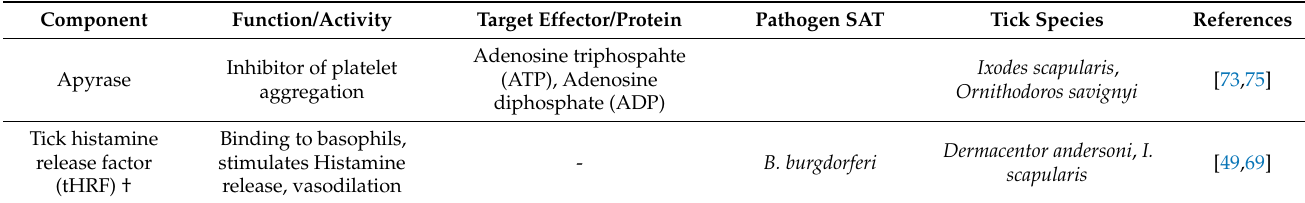
Figure 1. Secretion of anti-hemostatic (Salp14 and Iris) and immunomodulatory components (Salp15 and Iris) within tick saliva. Salp14 inhibits Factor Xa and the conversion of prothrombin to thrombin. Iris, an elastase inhibitor, hinders the intrinsic or contact-dependent coagulation pathway and platelet aggregation. The immunomodulatory protein, Salp15 prevents dendritic cell function by binding to the DC-SIGN (dendritic cell-specific intercellular adhesion molecule-3- grabbing non-integrin), a lectin receptor. This binding alters dendritic cell cytokine secretion. Additionally, Salp15 binds the CD4 glycoprotein on CD4+ T-helper cells, inhibiting the T-cell receptor signaling. Iris decreases the production and secretion of pro-inflammatory IL-6 and TNF- α by macrophages and affects T cell proliferation. Created with Biorender.com Table 1*. Characterized anti-hemostatic components secreted in tick saliva.